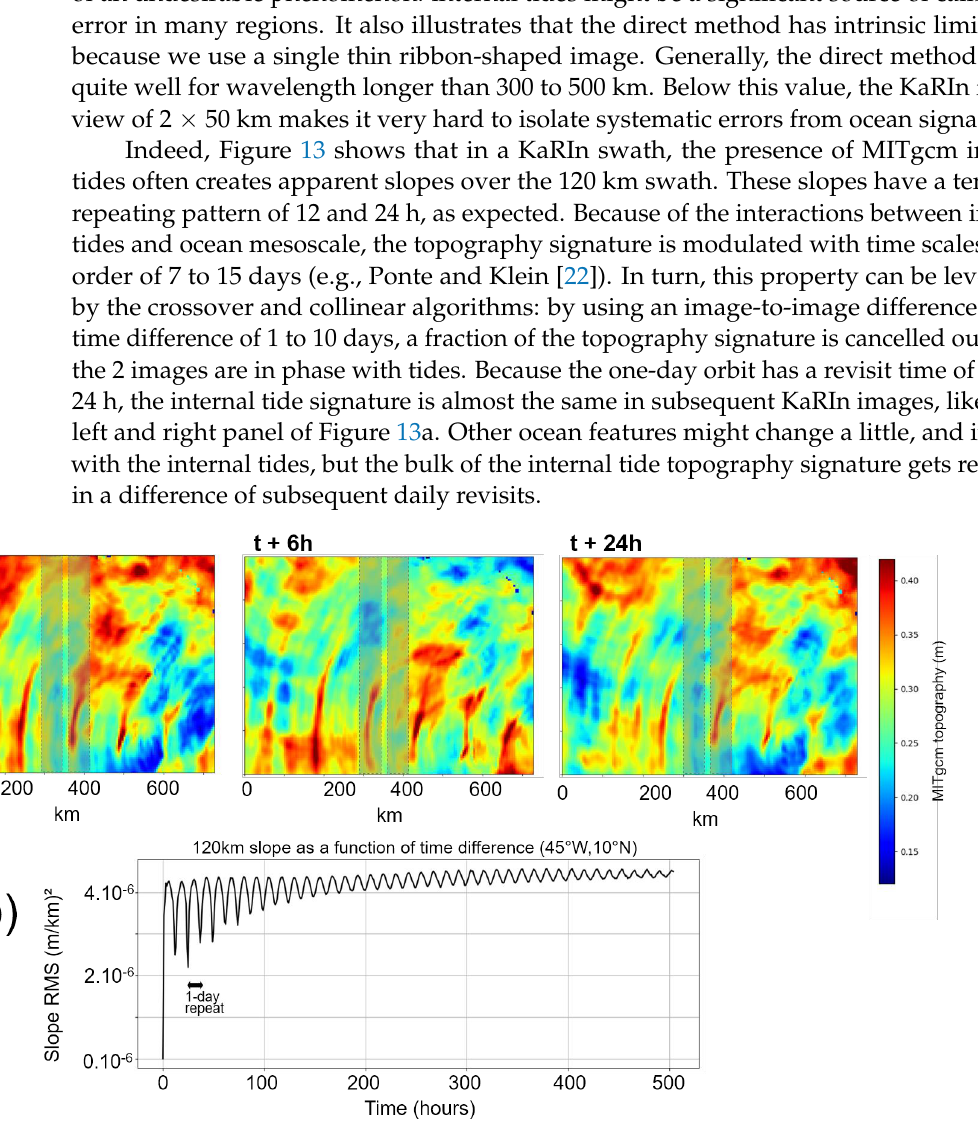
Figure 13. Illustration of the influence of internal tides in KaRIn images. Panel ( a ) shows MITgcm SSH snapshots for three arbitrary time steps (namely T0, T0 + 6 h, and T0 + 24 h) over a 700 × 500 km area in the Western Tropical Atlantic. The shaded region shows the geometry of a KaRIn image for scale. Panel ( b ) shows, the local ocean slope over 120 km as a function of time over a 21-day SWOT cycle.